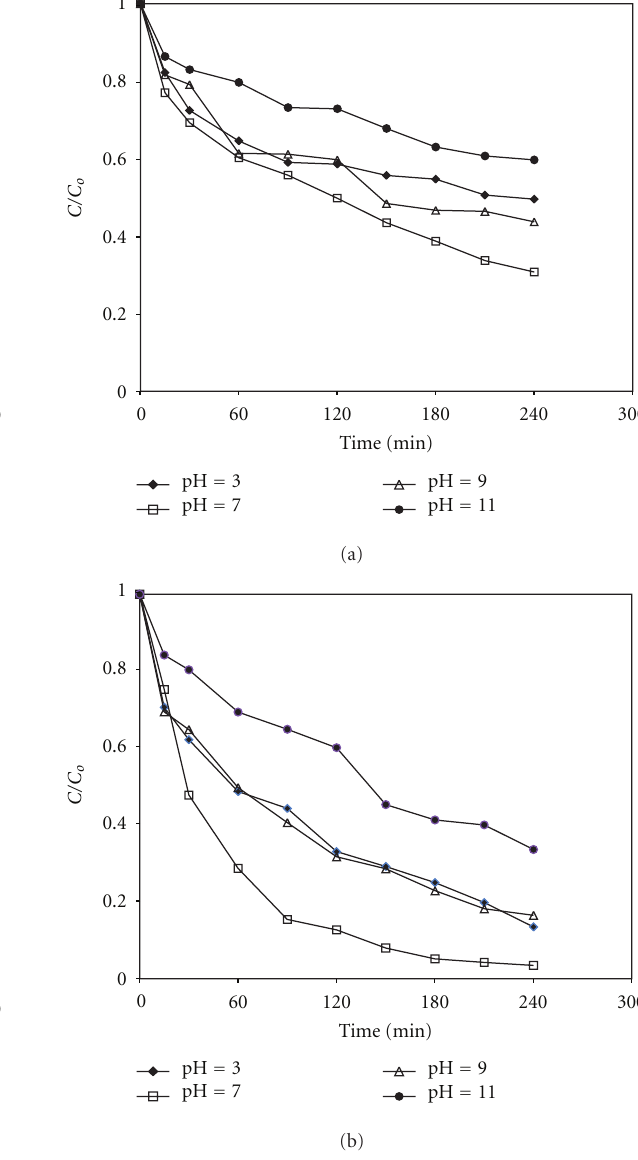
Figure 11: E ff ect of initial concentration on photocatalytic degra- dation: (a) phenol, (b) o- chlorophenol.